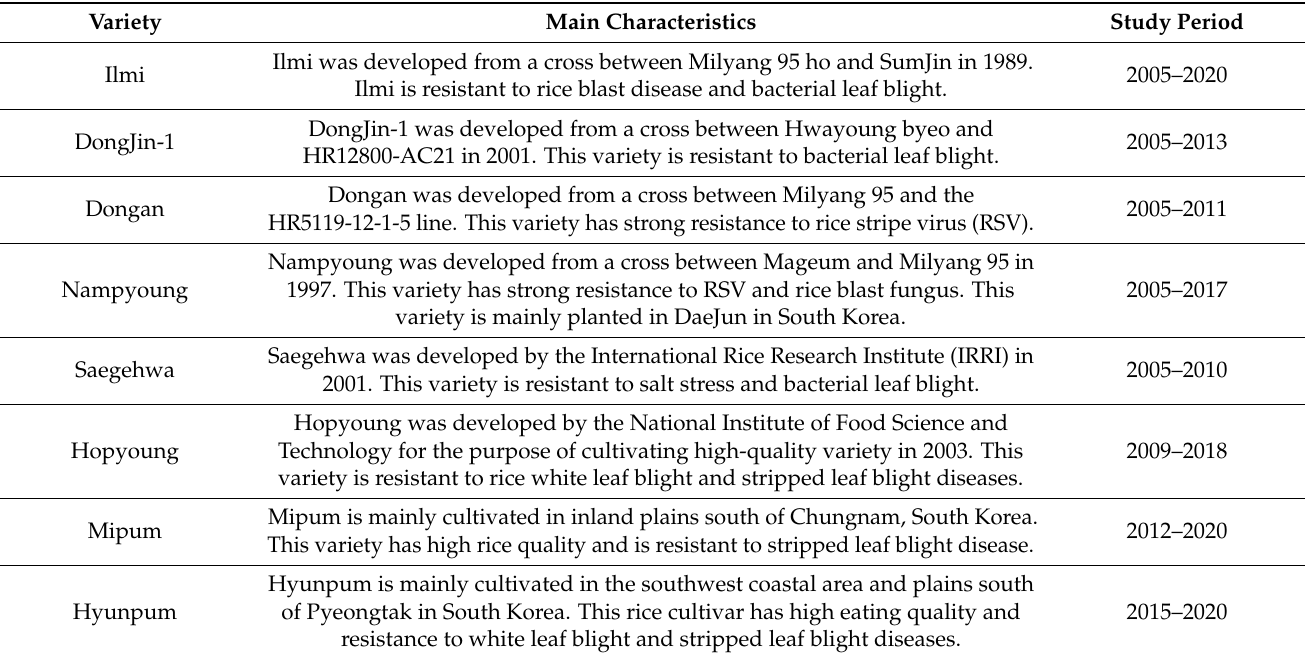
Table 1. The main characteristics of all eight medium to late maturing rice cultivars used in this study. Variety